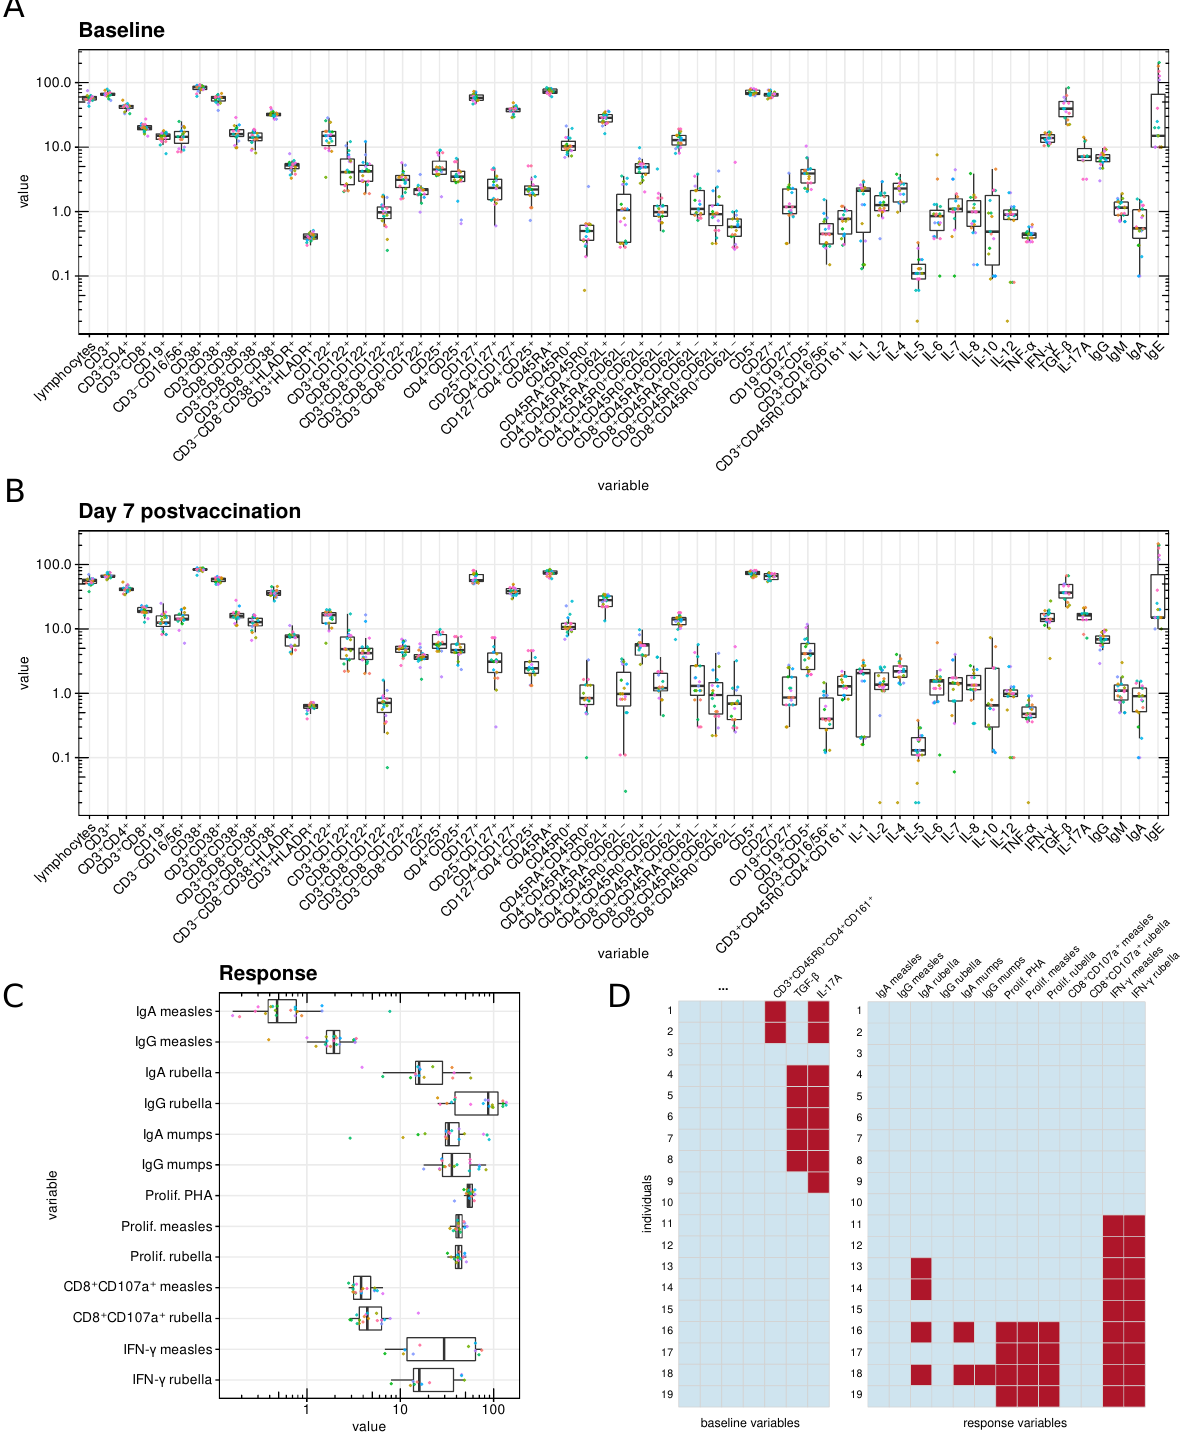
Figure 2. Collected data on baseline immune status and post-vaccination immune response. ( A – C ) Boxplots of measured immune status parameters at day 0 ( A ) and day 7 ( B ), and boxplot of post-vaccination response variables at day 42 ( C ). Points corresponding to the same individuals are marked with the same colors. ( D ) Indication of missing data for baseline and response variables (missing observations are colored in